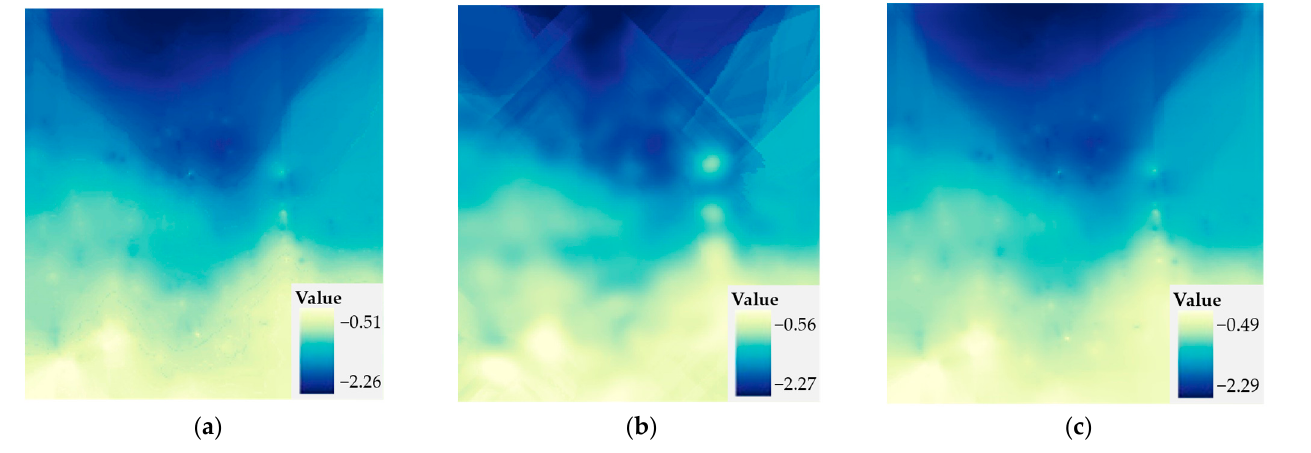
Figure 6. Bathymetric grid models produced by interpolation: ( a ) grid produced by Forest-based Classification and Regression method (grid FCR); ( b ) grid produced by Ordinary Kriging method (grid OK); ( c ) grid produced by IDW method (grid IDW).